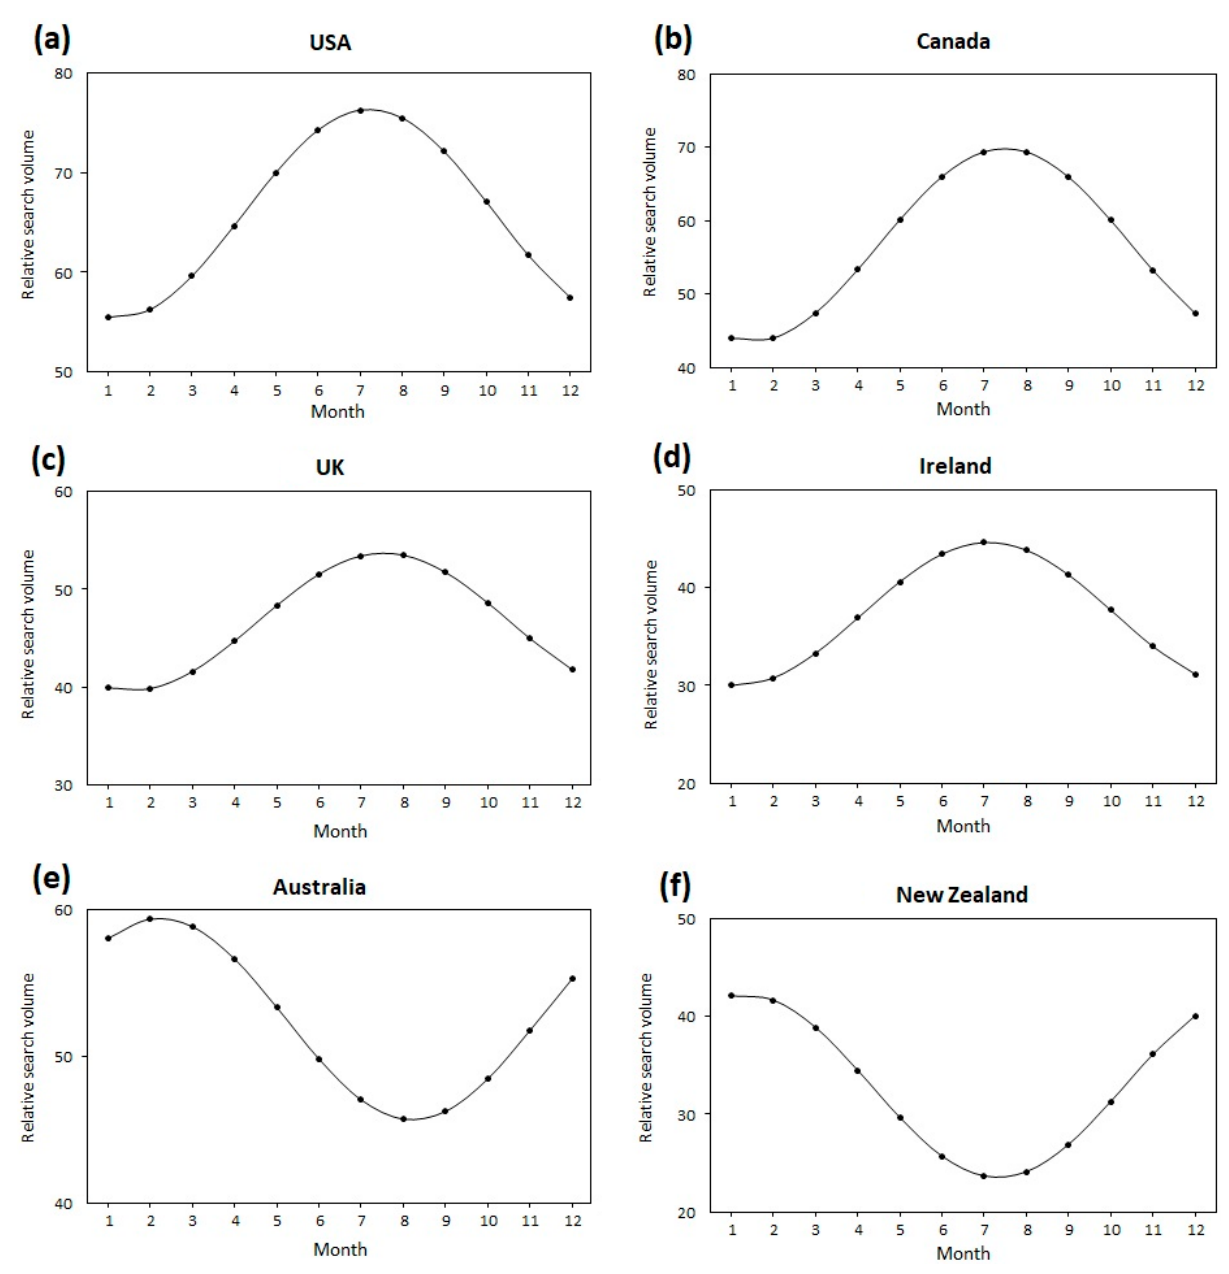
Figure 1. The plots of the cosinor model for seasonality in Google Trends search volume data for “plantar fasciitis” in ( a ) the USA, ( b ) Canada, ( c ) the U.K., ( d ) Ireland, ( e ) Australia, and ( f ) New Zealand. The numbers correspond to the months as follows: 1 = January; 2 = February; 3 = March; 4 = April; 5 = May; 6 = June; 7 = July; 8 = August; 9 = September; 10 = October; 11 = November; 12 = December.